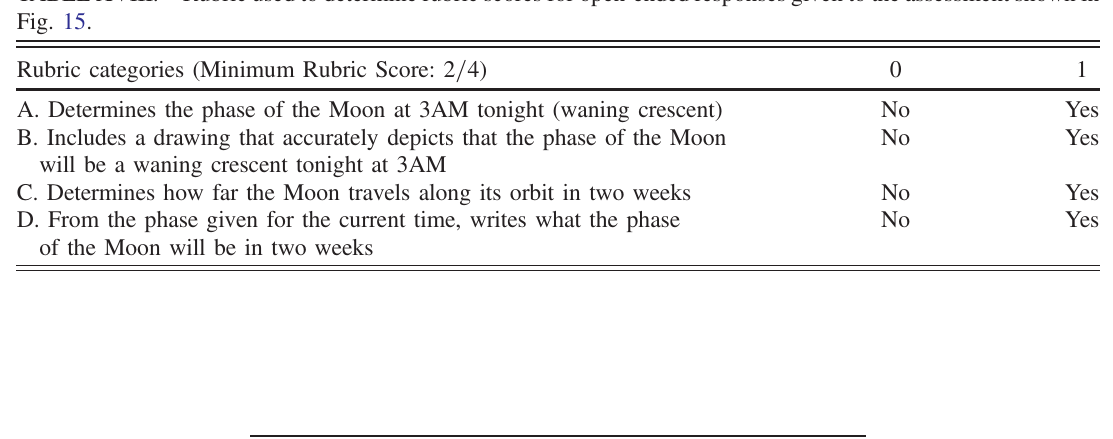
FIG. 15. Assessment used to measure students ’ ability to predict the phase of the Moon in two weeks given the current time and its current position on the observer ’ s horizon. The distributions of students choosing the correct multiple-choice response and attaining the minimum rubric score can be found in Fig. 8. This question was adapted from the Center for Astronomy Education exam